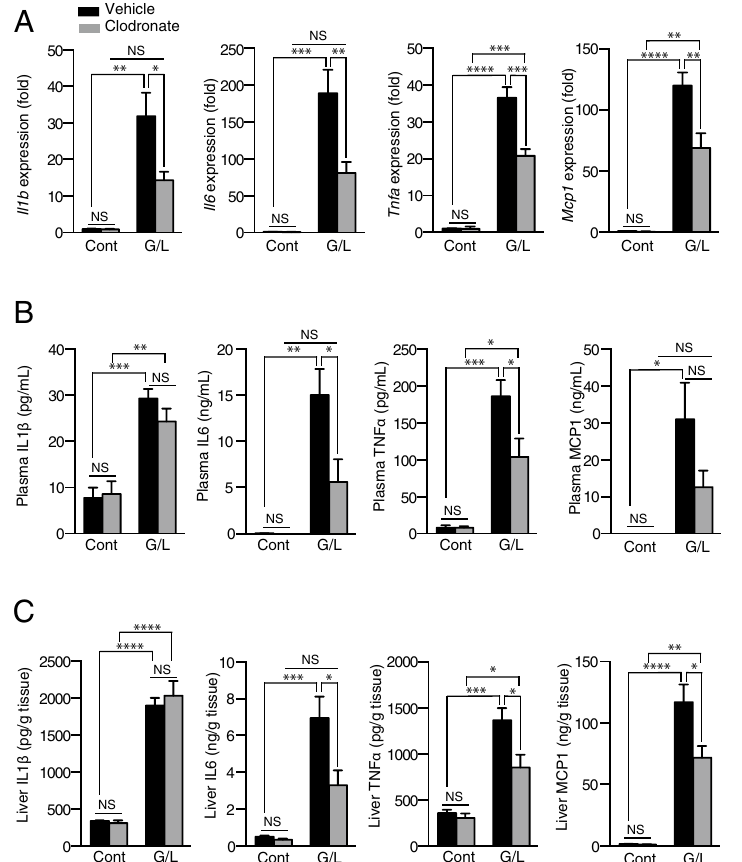
Figure 6. Clodronate suppresses inflammatory response in the plasma and liver of GalN/LPS-treated mice. The liver and plasma of mice treated as described in Fig. 6 were analyzed (n = 6 for the GalN/LPS administration group, per treatment; n = 3 for the control group, per treatment). ( A ) Hepatic mRNA levels of the inflammatory genes Il1β , Il6 , Tnfα , and Mcp1 were determined by qRT-PCR. (B, C) Plasma levels ( B ) and hepatic contents ( C ) of IL1β, IL6, TNFα, and MCP1 were determined using the BD Cytometric Bead Array. All data are shown as the mean ± S.E.M. * P < 0.05, ** P < 0.01, *** P < 0.001. NS not significant, Cont control (saline), G/L d-galactosamine and lipopolysaccharide